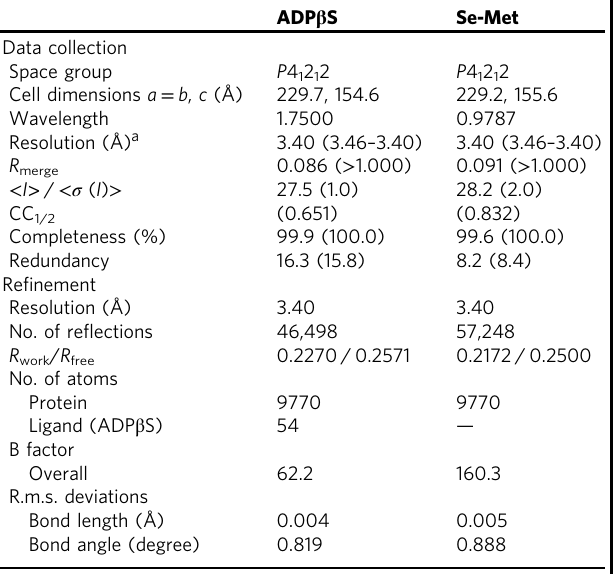
Table 3 Data processing and re fi nement